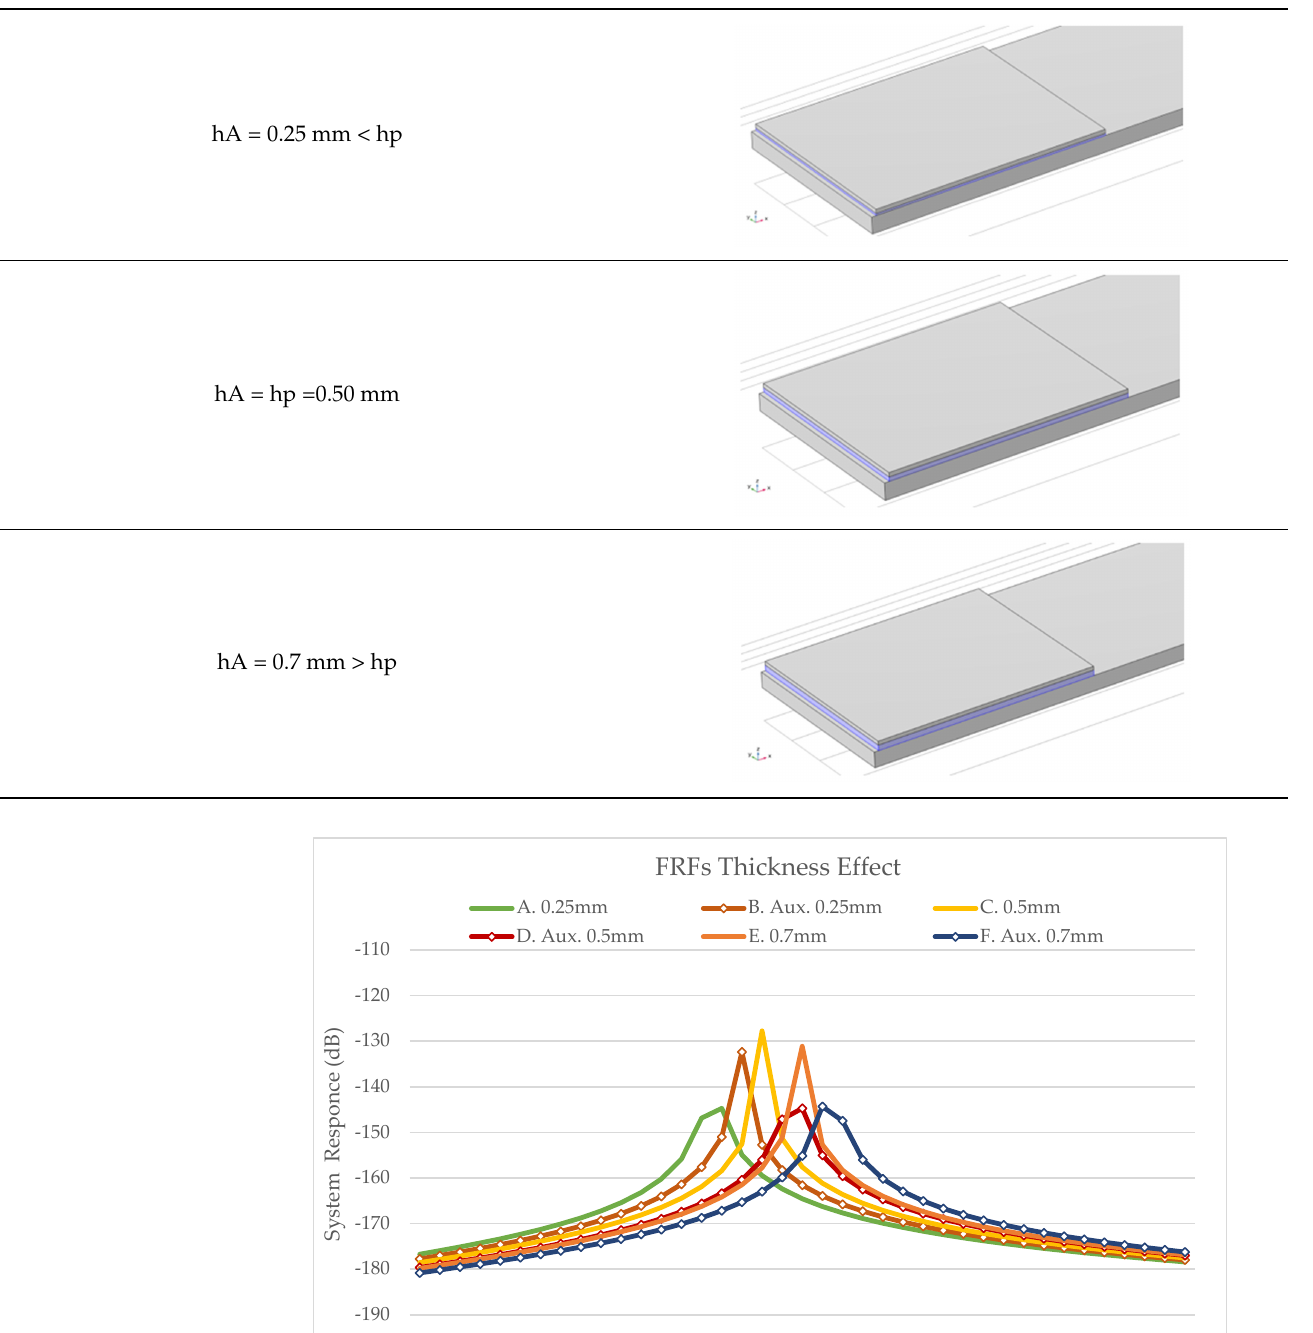
Table 8. Auxetic Composite Layer—Thickness Effect.